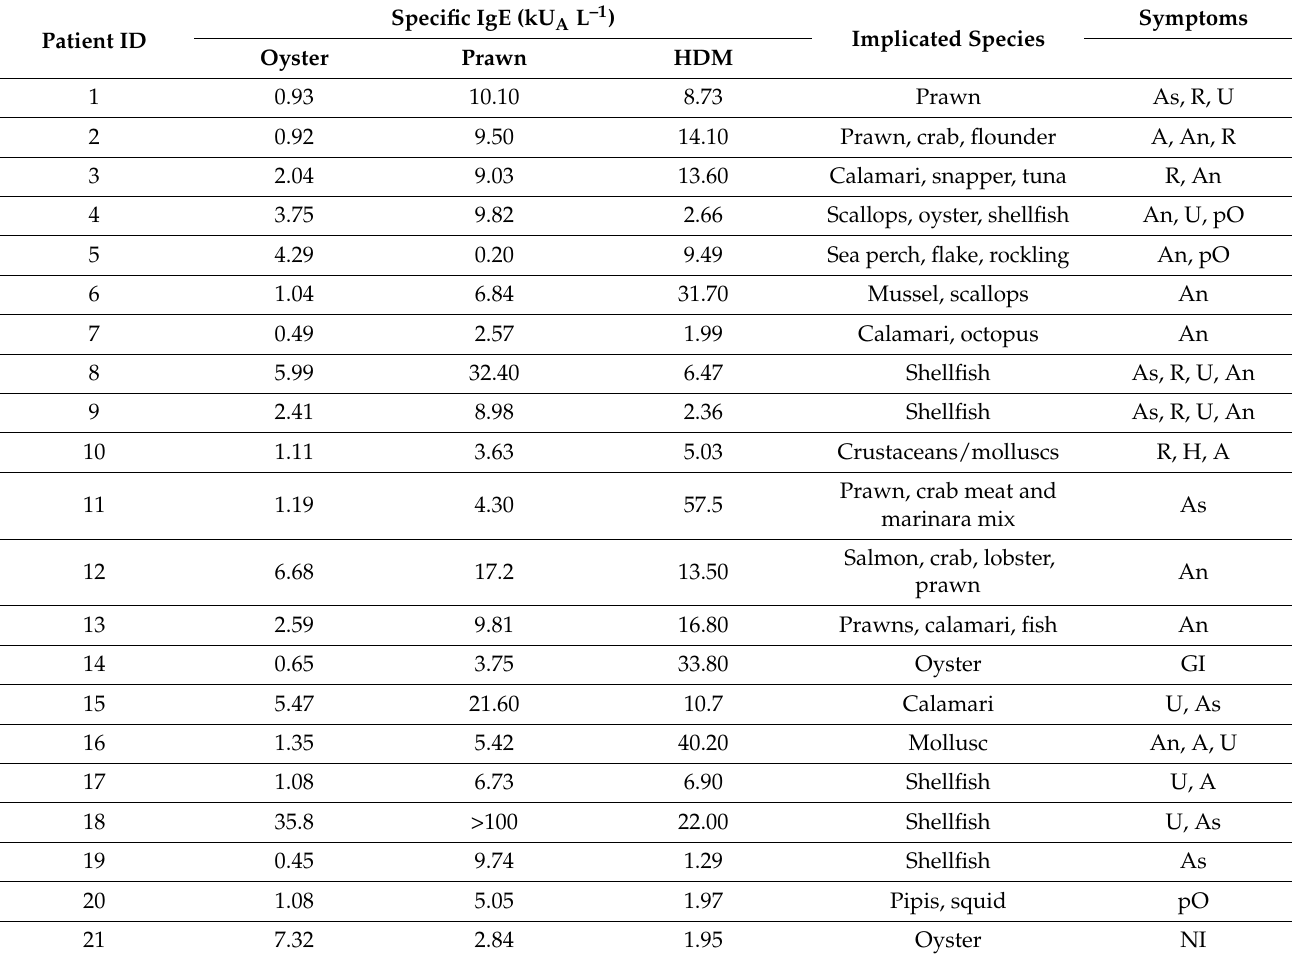
Table 1. Characteristics of shellfish-allergic patients recruited for this